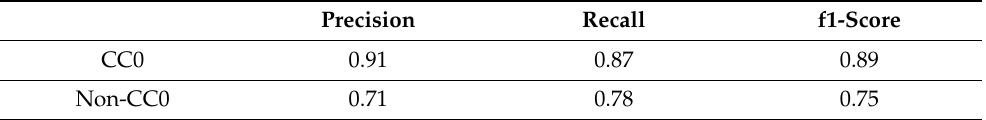
Figure 1. Prediction performance of the XGBoost model in the test cohort through the Receiver Operator Characteristic (ROC) (AUC = 0.866) plot demonstrating also the CI (AUC = 0.8–0.93). Note that the ROC curves depend on the order of the feature relative risk values without the need to choose a threshold. Table 2. Performance evaluation scores of the test cohort.